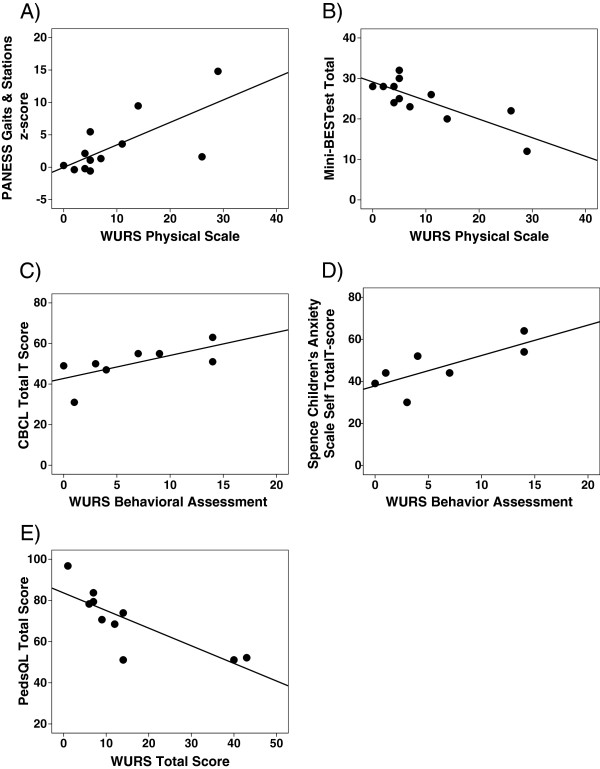
Scatterplots of WURS scales vs. other measures: A) PANESS Gaits & Stations z-score and WURS Physical Scale (rs= 0.67, p = 0.02) B) Mini-BESTest Total scores & WURS Physical Assessment (rs= -0.69, p = 0.01) C) CBCL Total T score and WURS Behavioral Assessment (rs= 0.77, p = 0.03) D) SCAS Total T score and WURS Behavioral Assessment (rs= 0.80, p = 0.03) E) WURS Total & PedsQL Parent Total Scores (rs= -0.86, p = 0.001).